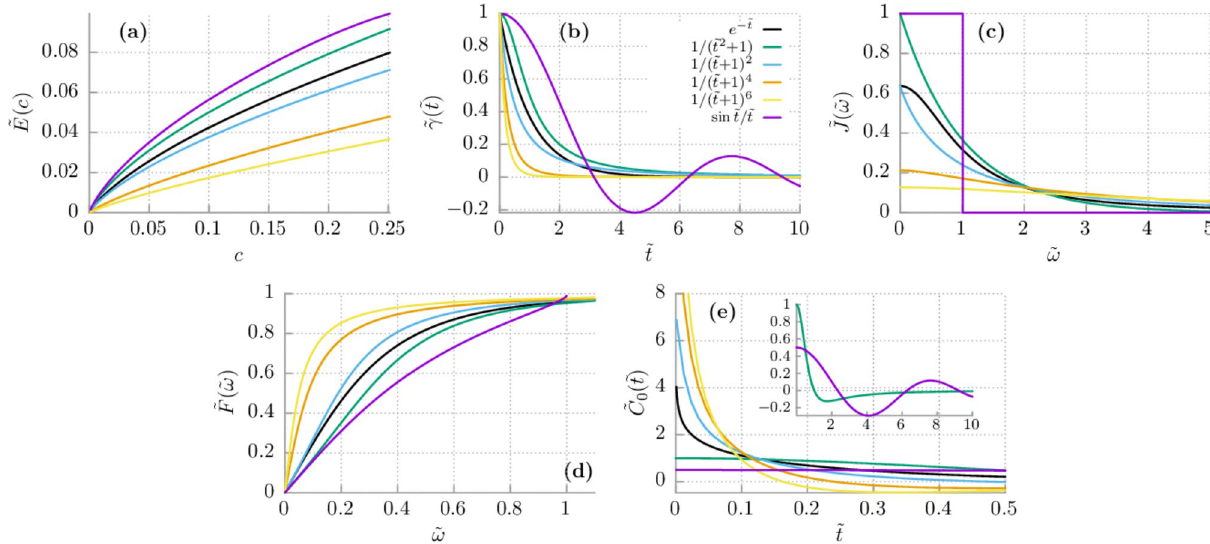
˜ E ( c ) depicted for different dissipation ˜ J ( ˜ ω) , ( d ) the cumulative distribution